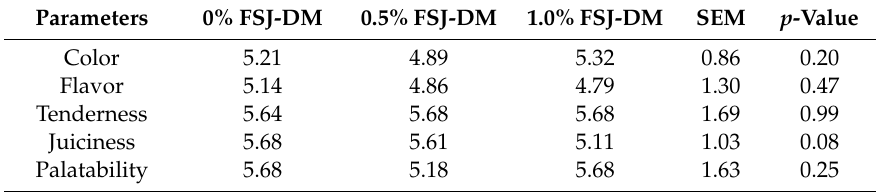
Table 5. Sensory attributes of meat from KNBG fed fermented S. japonica and D. morbifera (FSJ-DM).